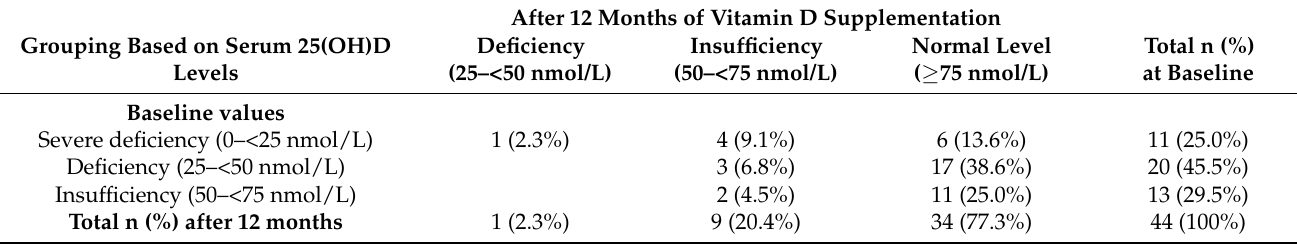
Table 3. Numbers and proportions of patients categorized by the 25(OH)D serum level at baseline and after 12 months of Vitamin D supplementation.